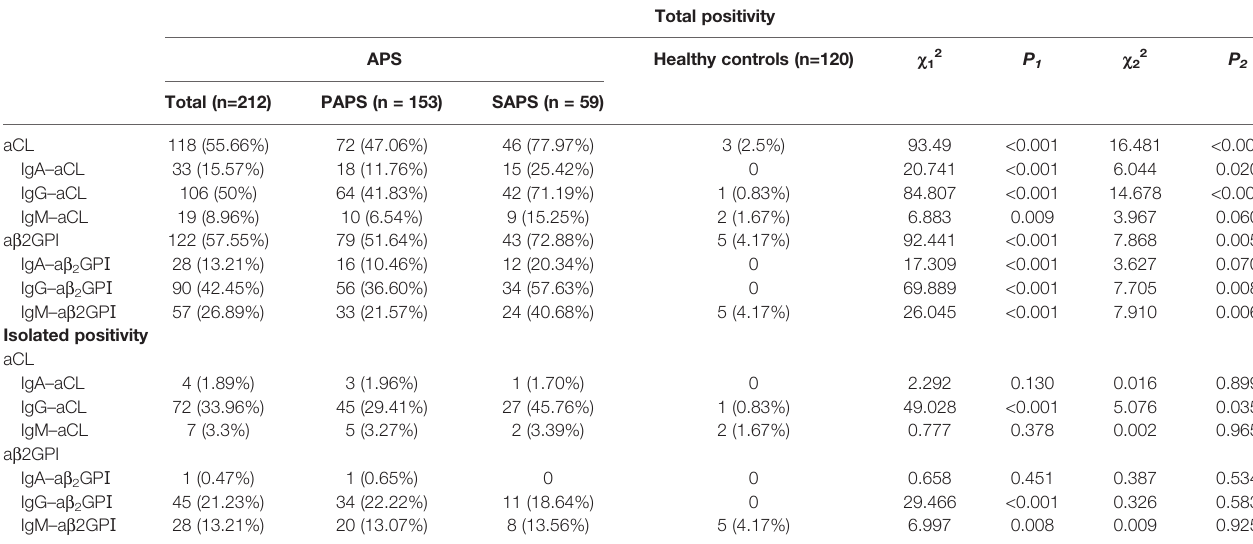
TABLE 4 | Pro fi le of antiphospholipid antibodies in patients with APS or healthy controls.